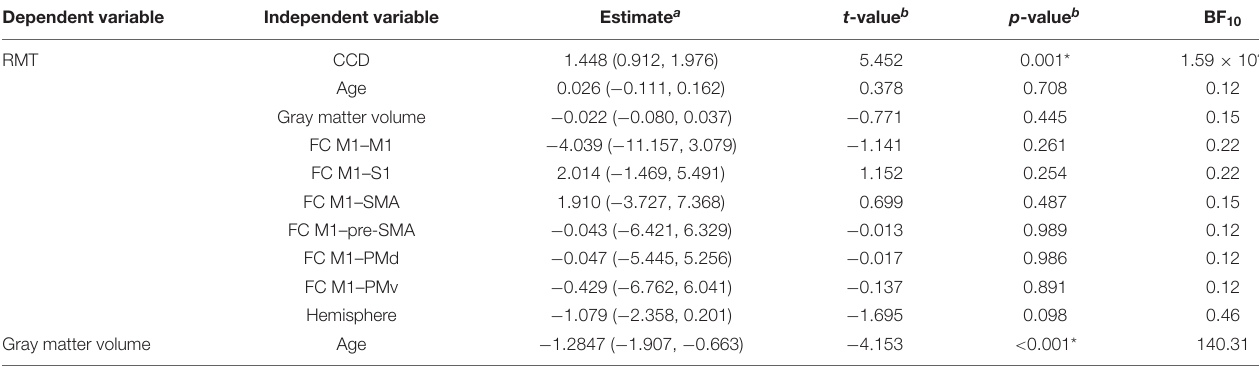
TABLE 3 | Linear mixed models with single variables using data from both hemispheres.